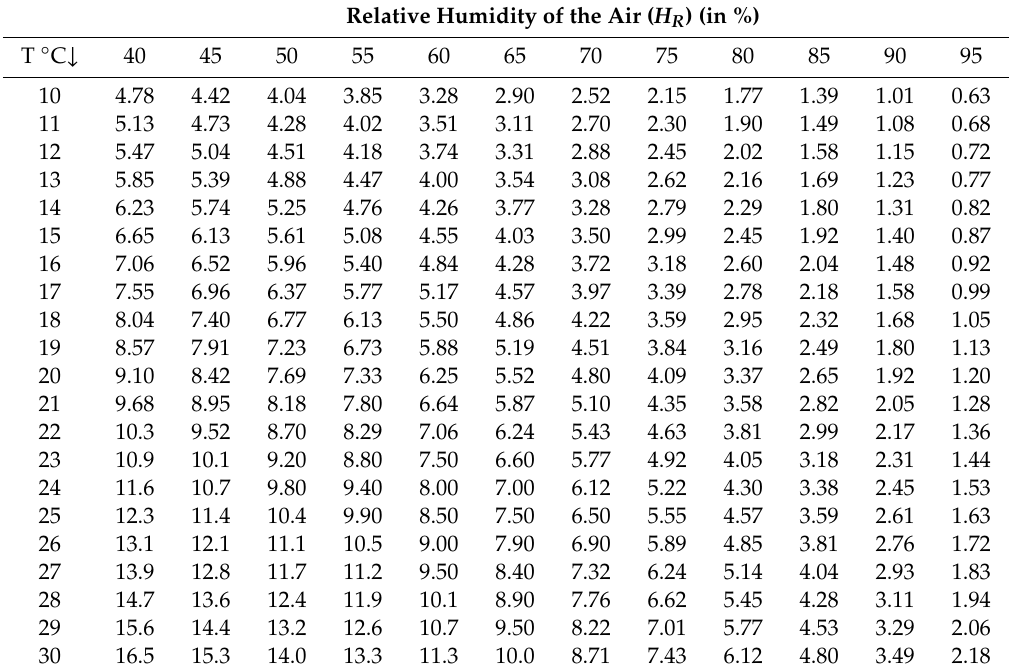
Table 1. Volume loss per year (in %) at different conditions of air temperature and relative humidity ( H R ). Relative Humidity of the Air ( H R ) (in